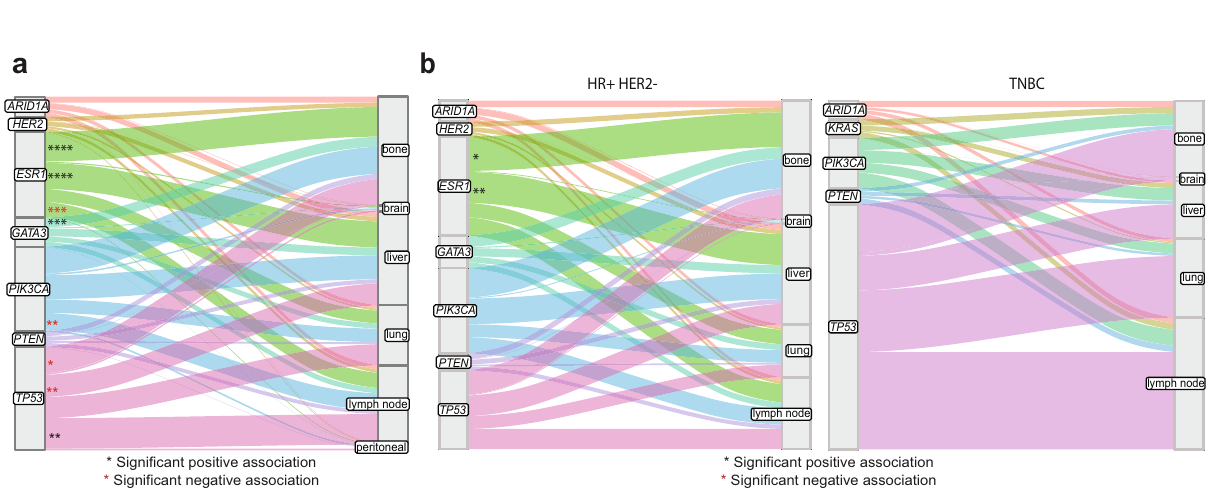
Fig. 4 Organotropism of mutations in advanced breast cancer. a Association of mutations in indicated genes with sites of metastasis. p -values from false discovery corrected two-sided Fisher ’ s exact test ( ESR1 : bone q < 0.0001, liver q < 0.0001, lymph node q = 0.0001; GATA3 : bone q = 0.0009; PIK3CA: lymph node q = 0.005; TP53 : lymph node q = 0.002, liver q = 0.002, bone q = 0.02). b Association of mutations in indicated genes with sites of metastasis in left HR + HER2- and right TNBC. p -values from false discovery corrected two-sided Fisher ’ s exact test (HR + HER2- ESR1 : liver q = 0.004, bone q =